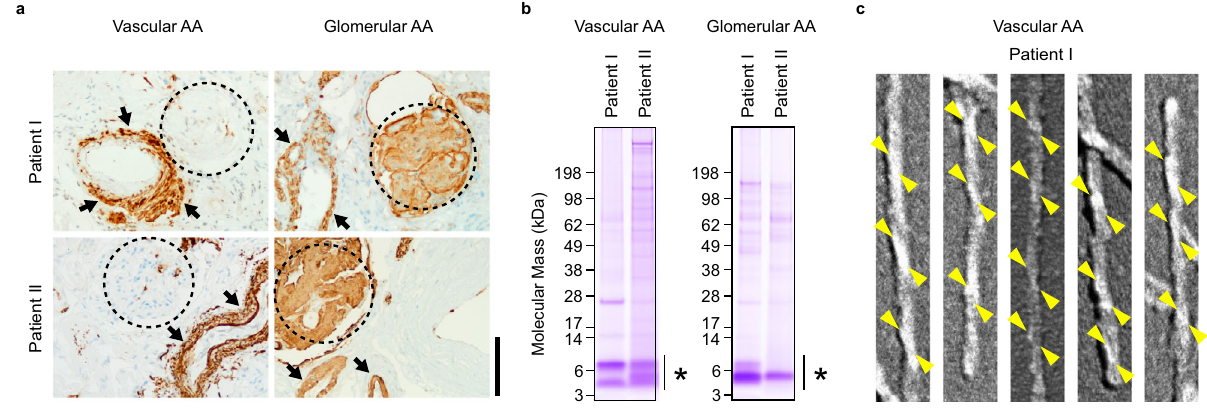
Fig. 1 | Comparison of vascular and glomerular amyloid deposits and fi brils. a Light microscopy images of renal tissue sections from two patients with the vascular or glomerular variant of systemic AA amyloidosis each (patients I and II). Each section was stained with anti-AA antibody (brown). Dotted lines: glomeruli. Black arrows: arteriole walls. Scale bar: 100 µ m. Each micrograph is representative for at least three micrographs recorded from the respective patient. b Coomassie blue-stained denaturing protein gels of the fi brils extracted from patient I and II.